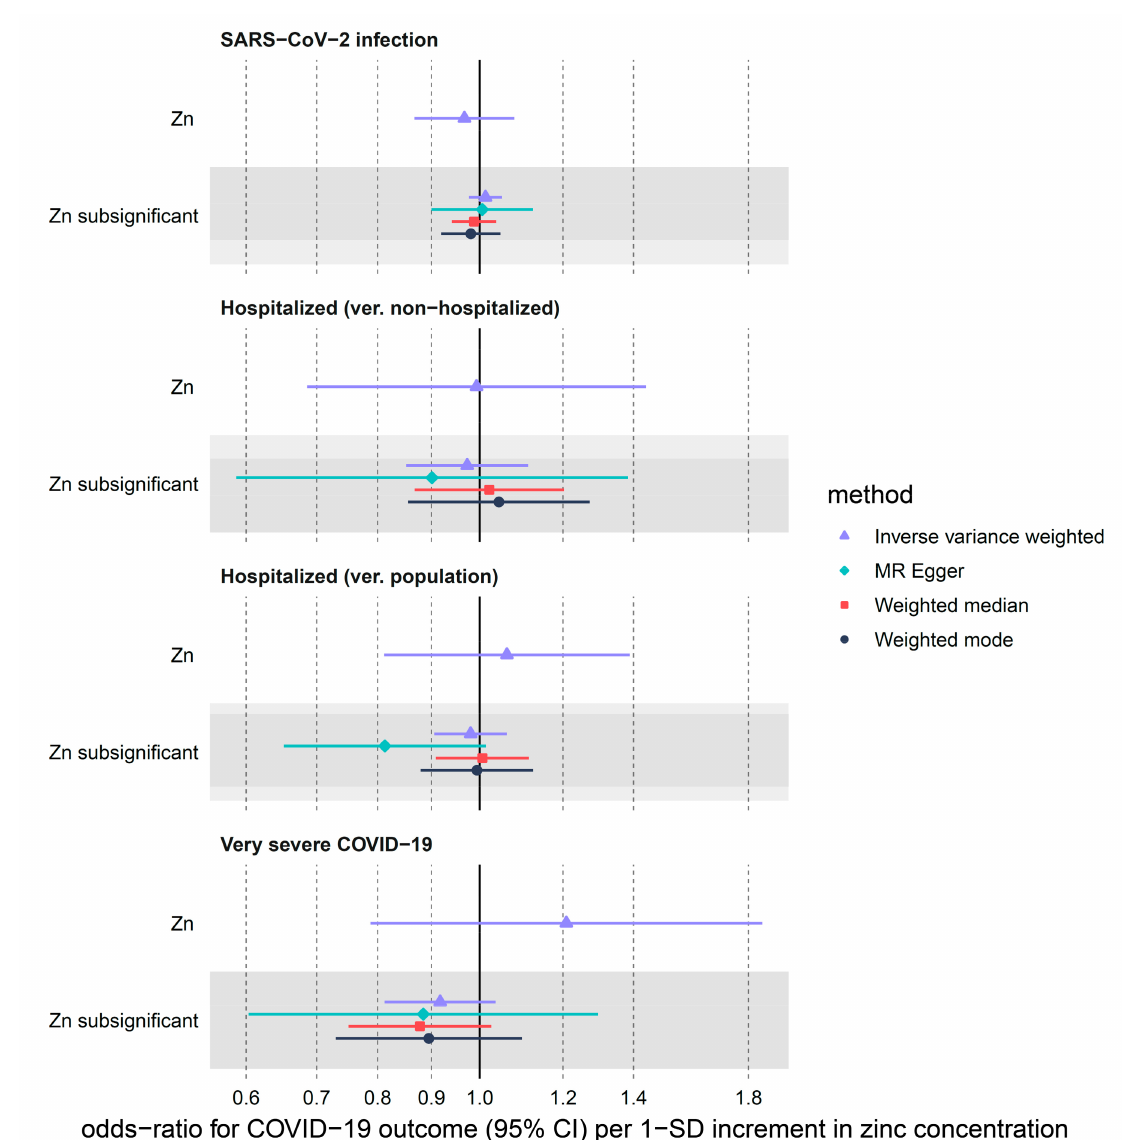
Figure 1. MR estimates for the effect of circulating zinc (Zn) on three COVID-19 outcomes obtained using 4 different statistical methods. We used two sets of zinc instruments: Zn refers to instruments with p -values < 5 × 10 − 8 and sub-significant Zn refers to instruments with p -values < 5 × 10 − 5